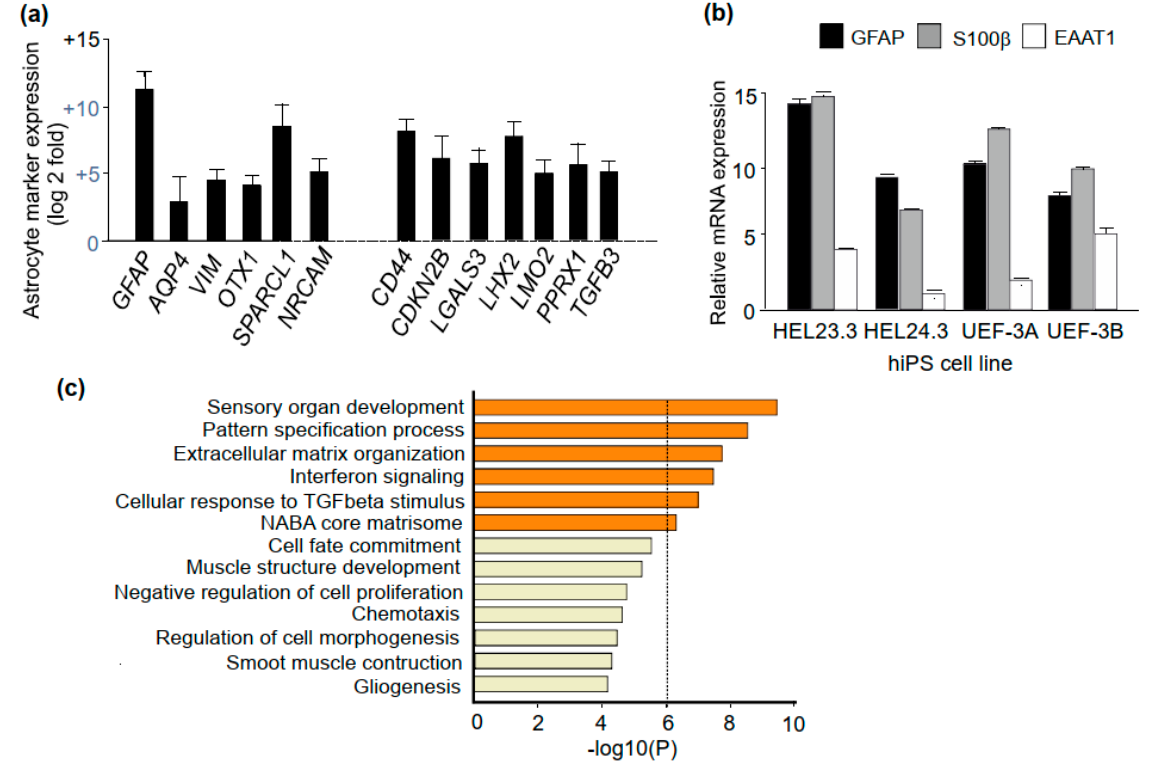
Figure 4. Molecular signature of D95 astrocytes. ( a ) Enriched expression of astrocyte markers relative to neurosphere expression in RNA-seq data of D95 astrocytes (log2-fold, p < 0.05, p adjust < 0.1; duplicate samples). ( b ) Expression of GFAP, S100b, and EAAT1 mRNA in D95 astrocytes. n = 3 cell lines. ( c ) Enriched ontology clusters in D95 astrocytes.